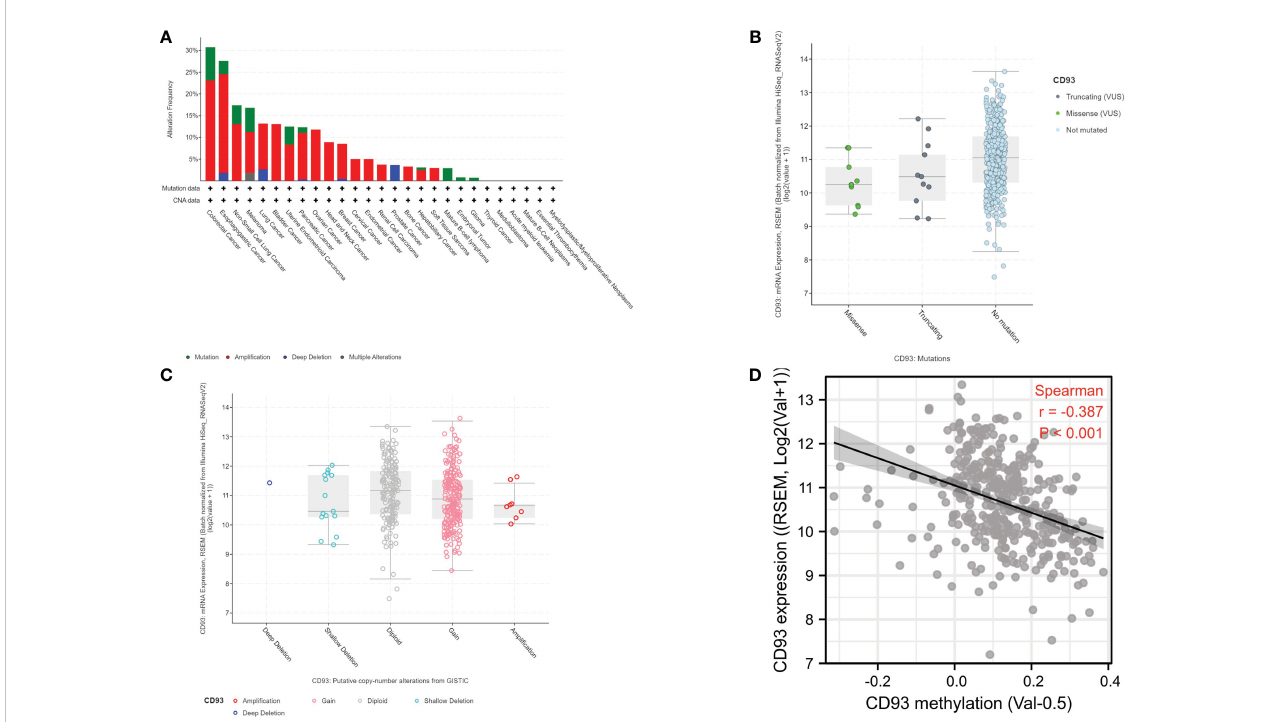
FIGURE 2 (A) CD93 mutation frequency in stomach adenocarcinoma (STAD) according to the cBioportal database. (B) CD93 expression level in different mutation types in STAD according to the cBioportal database. (C) CD93 expression level in different copy number variation types in STAD according to the cBioportal database. (D) Correlation between CD93 expression and CD93 methylation in STAD (Spearman, r = -0.387, p <